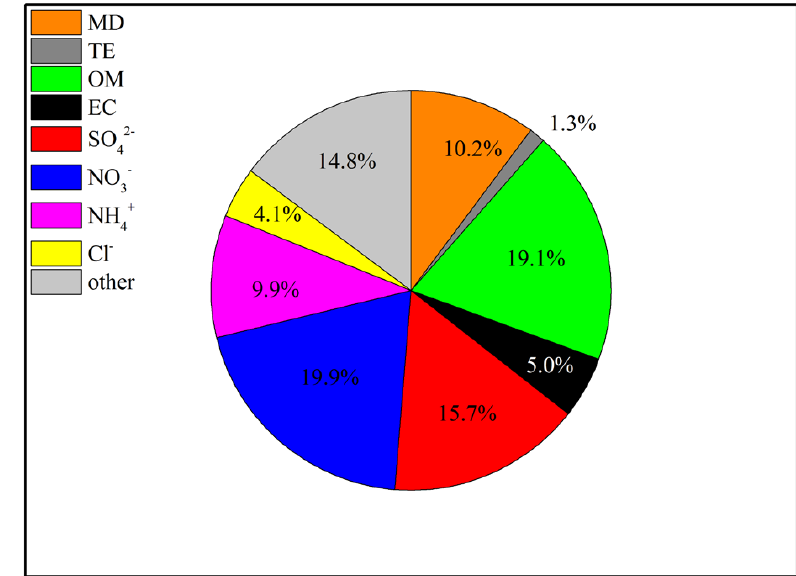
Figure 3. Average concentrations of chemical components in PM 2.5 (data shown in blue are the primary component >1.0 μg m −3 , while data shown in red are <1.0 μg m −3 ).